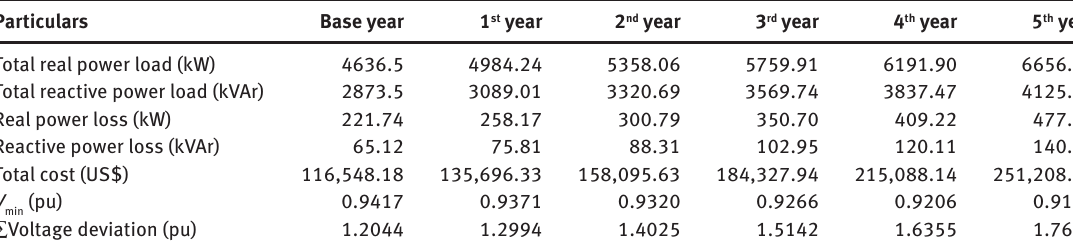
Table 10: Year-wise Analysis on the 34-Bus Distribution System without OSCsP. Particulars